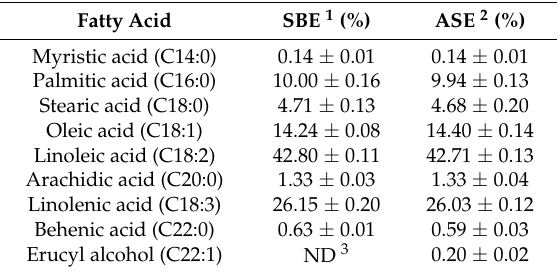
Table 2. Fatty acid composition of the fenugreek seed oils extracted by different